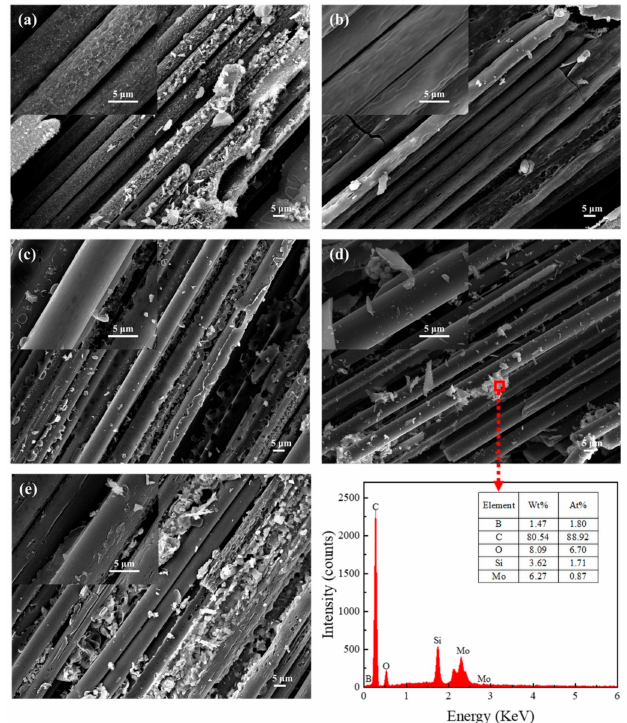
Figure 12. Micromorphology of the ablated surface for composites modified with different B 4 C content: ( a ) BP-0, ( b ) BP-5, ( c ) BP-10, ( d ) BP-15, and ( e ) BP-20. EDS analysis of oxyacetylene ablation sample of BP-15.